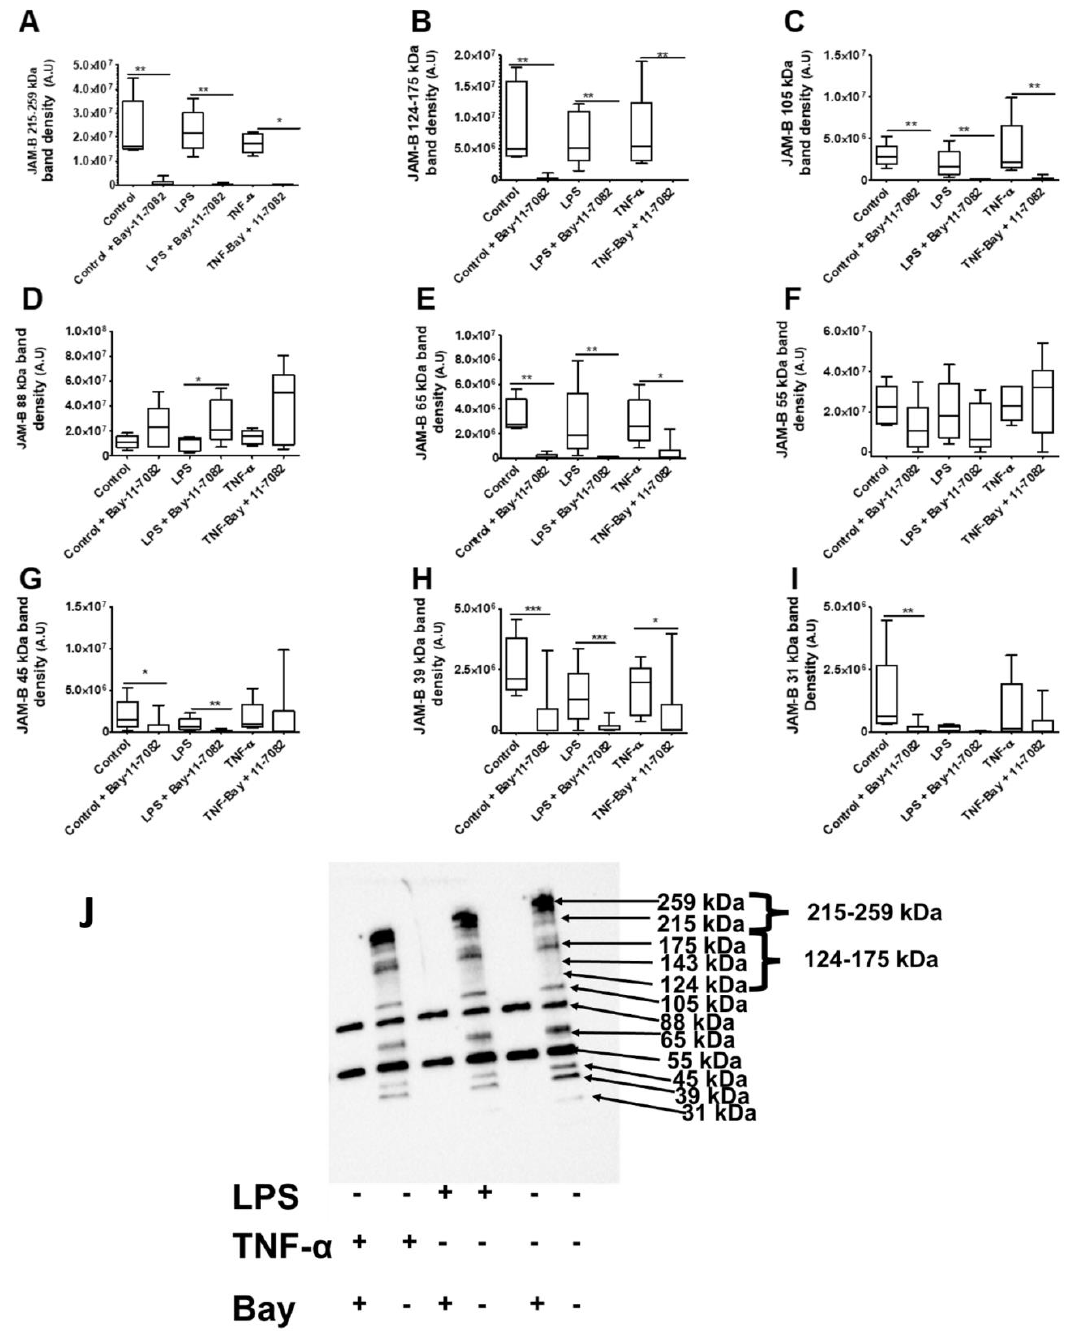
Figure 12. Effects of the Bay-11-7082 inhibitor on the abundance of JAM-B protein species in THP-1 monocyte cytosolic cell lysates after incubation with and without inflammatory stimuli (relative to total protein on stain-free gel): ( A ) 215–259 kDa bands, ( B ) 124–175 kDa bands, ( C ) 105 kDa band, ( D ) 88 kDa band, ( E ) 65 kDa band, ( F ) 55 kDa band, ( G ) 45 kDa band, ( H ) 39 kDa band, ( I ) 31 kDa band and ( J ) blot images showing protein band densities in the Bay-11-7082 inhibitor-treated THP-1 cytosolic cell lysates in the presence and absence of inflammatory stimuli. A.U, arbitrary units; * indicates p ≤ 0.05, ** indicates p ≤ 0.01, *** indicates p ≤ 0.001 after Mann–Whitney U test ( n =